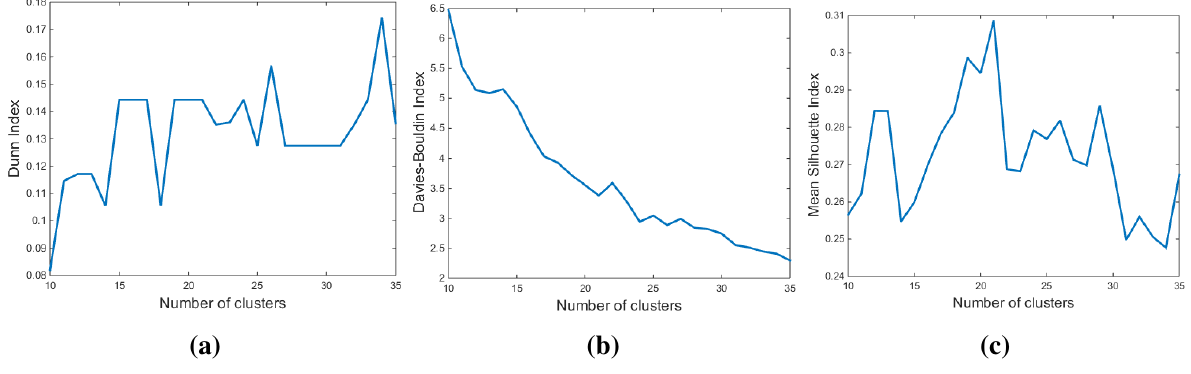
Figure 5. Validating the quality of the clusters produced by K -means algorithm in site A.